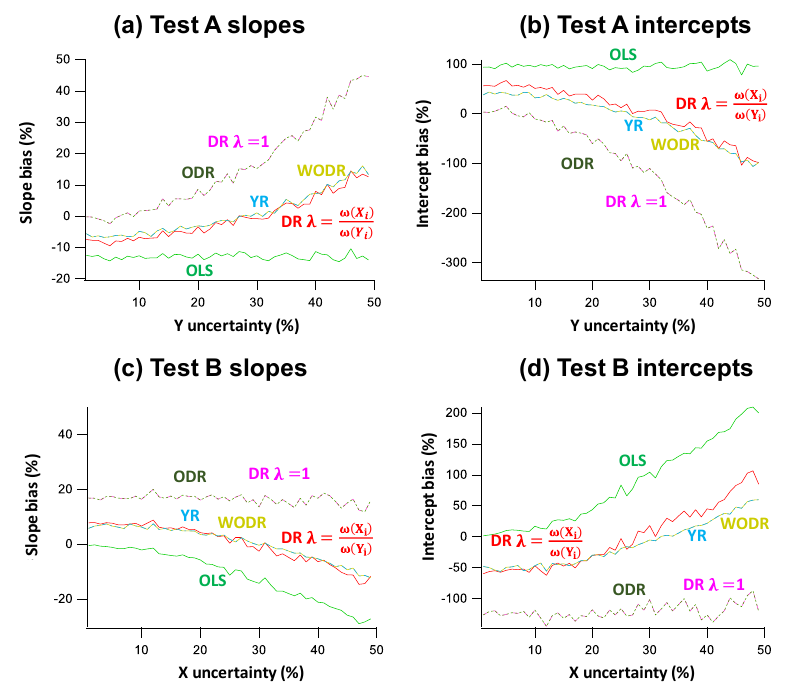
Figure 6. Slope and intercept biases by different regression schemes in two test scenarios (A and B) in which the assumed error for one of the regression variables deviates from the actual measurement error. In Test A data generation, γ Unc_X is fixed at 30% and γ Unc_Y is varied between 1 and 50%. In Test B, γ Unc_X varies between 1 and 50% and γ Unc_Y is fixed at 30%. The assumed measurement error for regression is 10% for both X and Y . (a) Slope biases as a function of γ Unc_Y in Test A. (b) Intercept biases as a function of γ Unc_Y in Test A. (c) Slope biases as a function of γ Unc_X in Test B. (d) Intercept biases as a function of γ Unc_X in Test